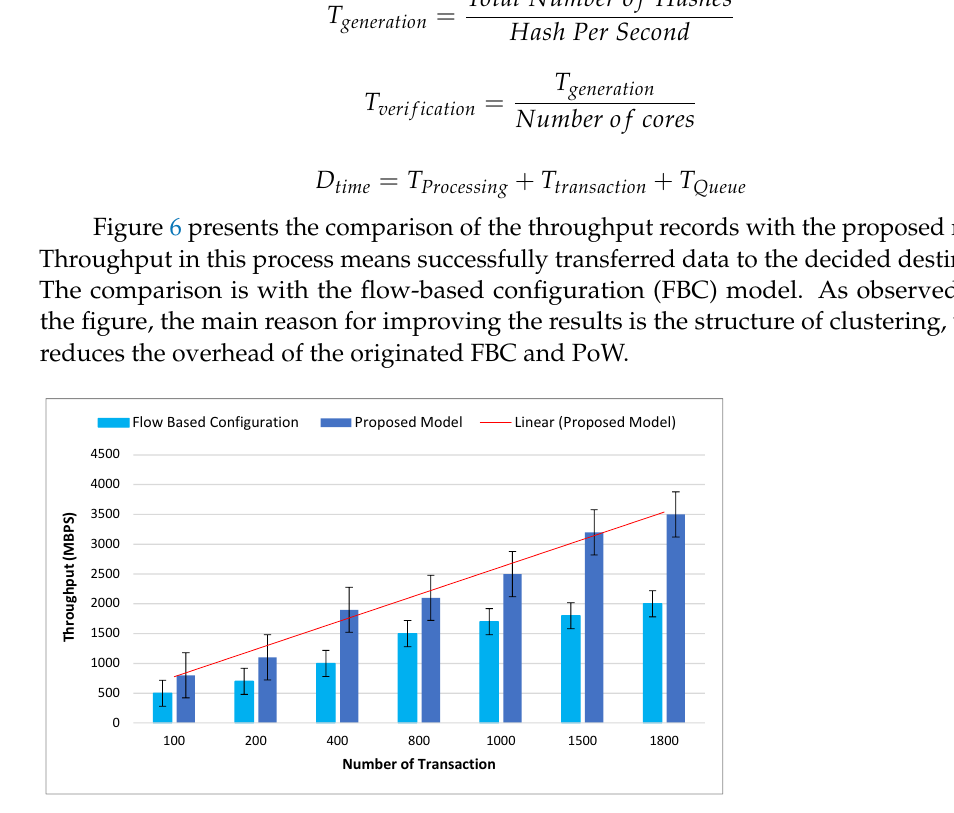
Figure 6. Comparison of the proposed model with throughput.